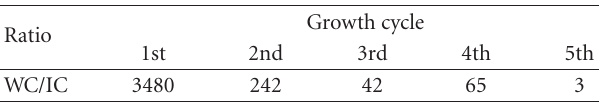
Table 4: Above-ground biomass ratios of B. tectorum grown with- out competition (WC) to B. tectorum grown in competition (IC), by growth